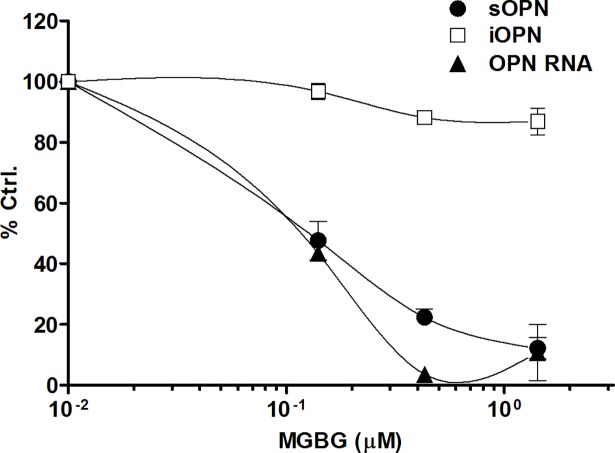
MGBG inhibited sOPN levels and gene expression in cultured human monocytes.1 day cultured monocytes were collected for total RNA extraction and iOPN expression, and culture supernatants for OPN ELISA; quantitative real-time PCR was performed for OPN gene expression. iOPN expression was measured by flow cytometry. MGBG decreased OPN gene expression and sOPN level in a dose-dependent manner. MGBG slightly decreased iOPN expression. The data were normalized against that of untreated controls. The average sOPN level for 1 day untreated monocytes was approximately 3 ng/ml. The iOPN geometric mean florescence of 1 day untreated cells varies among individuals ranging from 209–689. The OPN RNA level was calculated from β-actin normalized Ct difference of 1D cultured cells versus cells at isolation. The OPN Ct difference of 1 day untreated monocytes also varies among individuals ranging from 1.7 to 9.9. ED50 of MGBG on OPN cytokine level and gene expression on day 1: ~ 0.1 μM, n = 4, means and SEM.